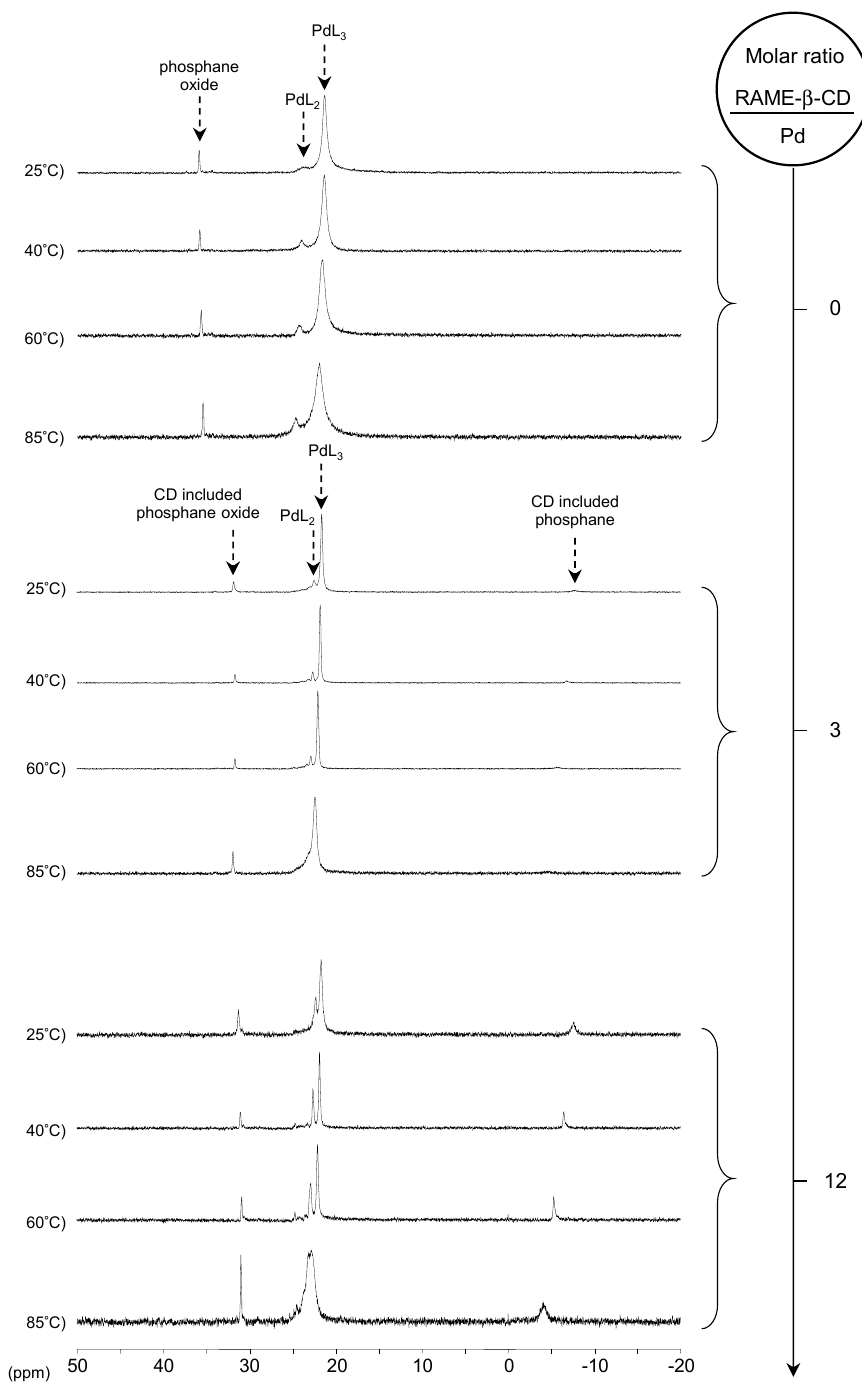
Figure 12. 31 P{ 1 H} NMR spectra of palladium complexes synthetized with P(Biph) 2 PhTS depending on both temperature and RAME- β -CD quantity in D 2 O with a ligand concentration of 66 mM.